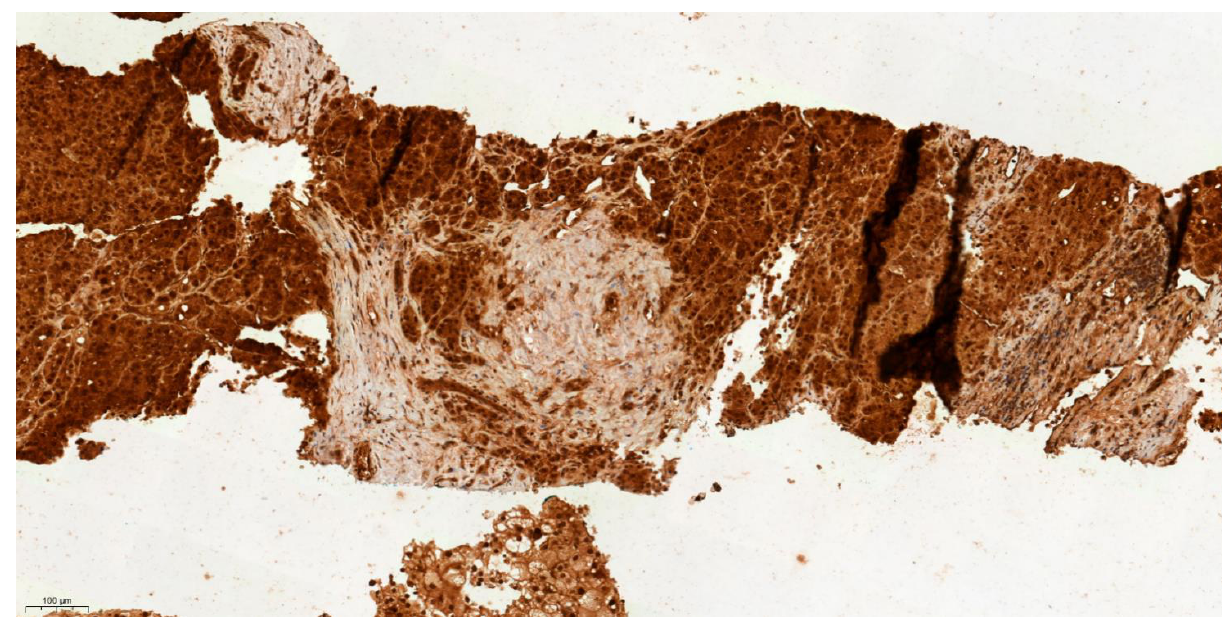
Figure 3. IHC characteristics of kallikrein-6 (KLK6) in HCC at low power magnification (X10). The brown chromogen indicated protein expression of KLK6 in the nucleus and cytoplasm of the hepatic and stromal cells. Slide shows infiltrating nests and cords of atypical hepatocytes in the stroma with mildly pleomorphic nuclei in keeping with moderately differ- entiated hepatocellular carcinoma, demonstrating high intensity of nuclear and cytoplasmic staining for KLK 6 (Allred score 3).